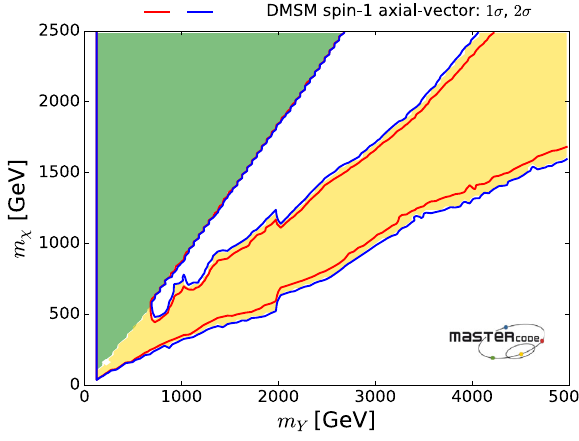
Fig. 8 Contours of the likelihood in the ( m χ ,σ SI p ) plane for the vector- like model, showing the current upper limits from the LUX [76], PANDAX-II[77]andXENON1T [78]experiments(rescaledtoaccount for the different local DM density that we assume), together with the neutrino ‘floor’ [102,103] (shown as the dashed orange line), and the range of σ SI p that will be probed by the upcoming experiments LZ [100] and XENONnT [101]. We again use colour coding to illustrate the dominant mechanisms bringing the DM density into the allowed range: green for annihilation via t -channel χ exchange into pairs of mediator particles Y that subsequently decay into SM particles, and yellow for rapid annihilation directly into SM particles via the s -channel Y reso- nance. We indicate the effective lower limit on m χ that is imposed by our sampling limit on m Y